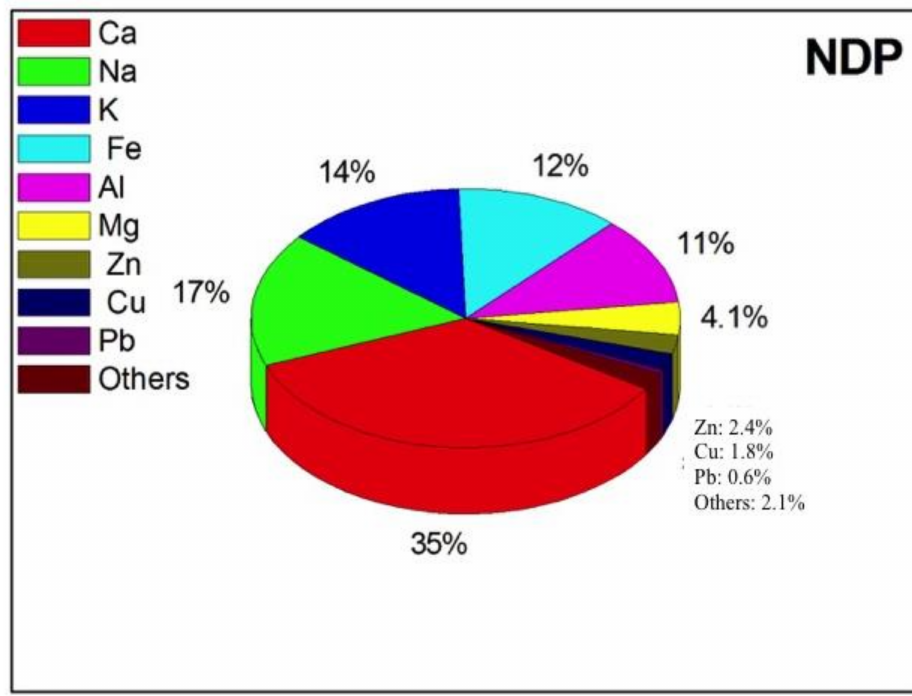
Figure 2. Percentage contributions of selected metals collected during FDP and